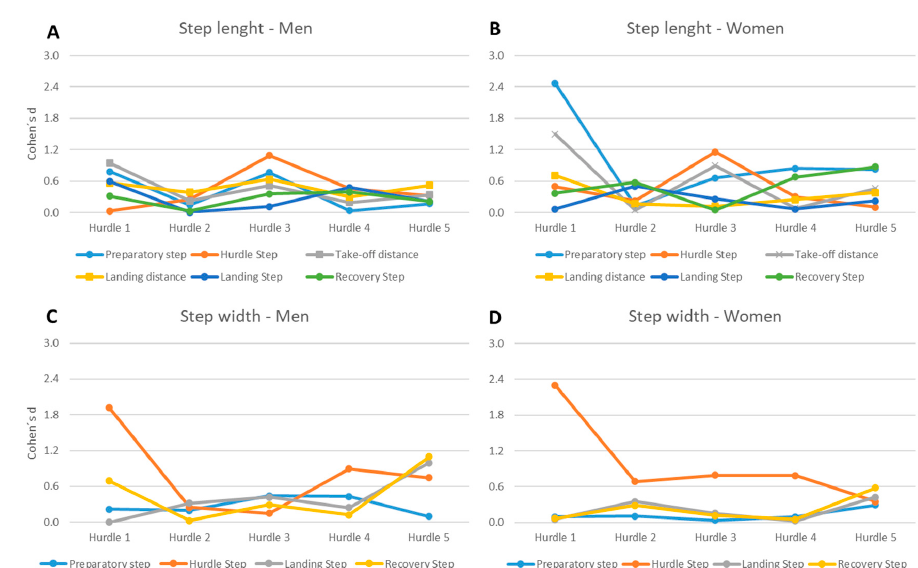
Figure 3. Magnitude of differences (Cohen’s d) for the spatial parameters (( A , B ) step length; ( C , D ) step width) in relation to mean race values for men and women. An effect size greater than 0.6 or 1.2 was considered as moderate or large, respectively, by Hopkins et al. [25]. Table 2. Evolution of the spatial-temporal variables of men hurdlers participating in the 44th Spanish Indoor and 12th IAAF World Indoor Championships.